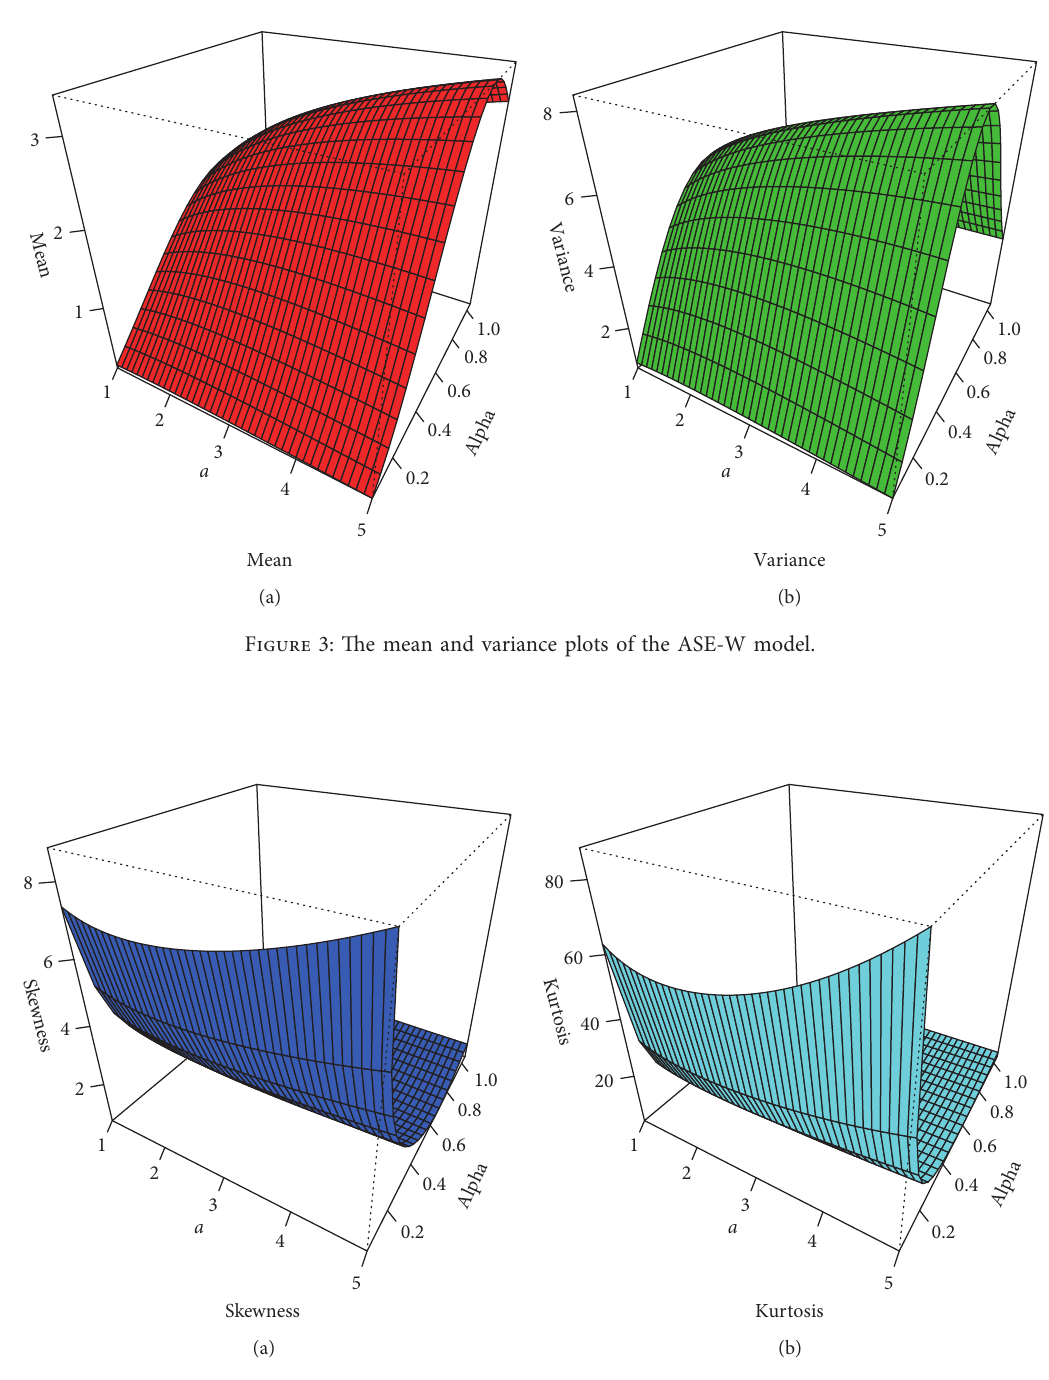
Figure 4: The skewness and kurtosis plots of the ASE-W